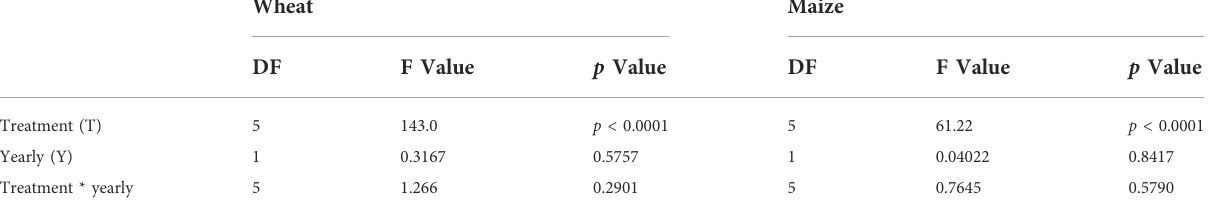
TABLE 2 Effects of fertilizer management practices and years on crop